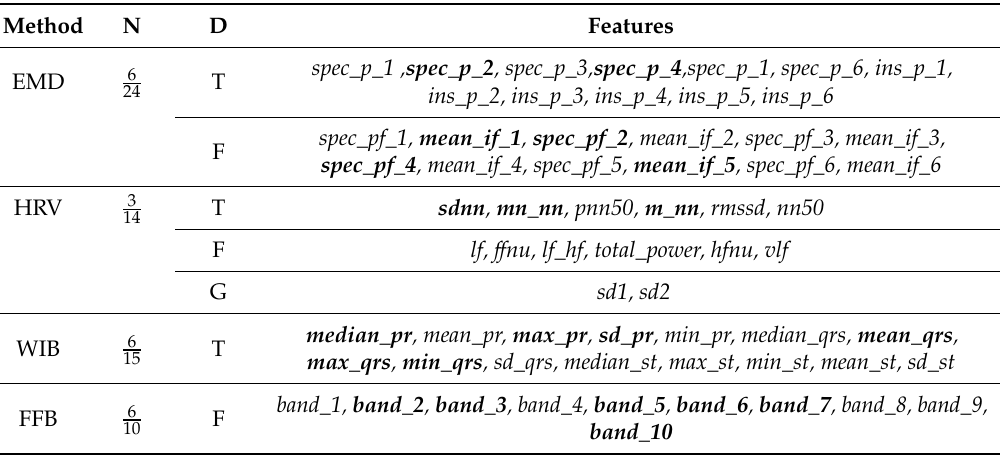
Table 6. Feature selection